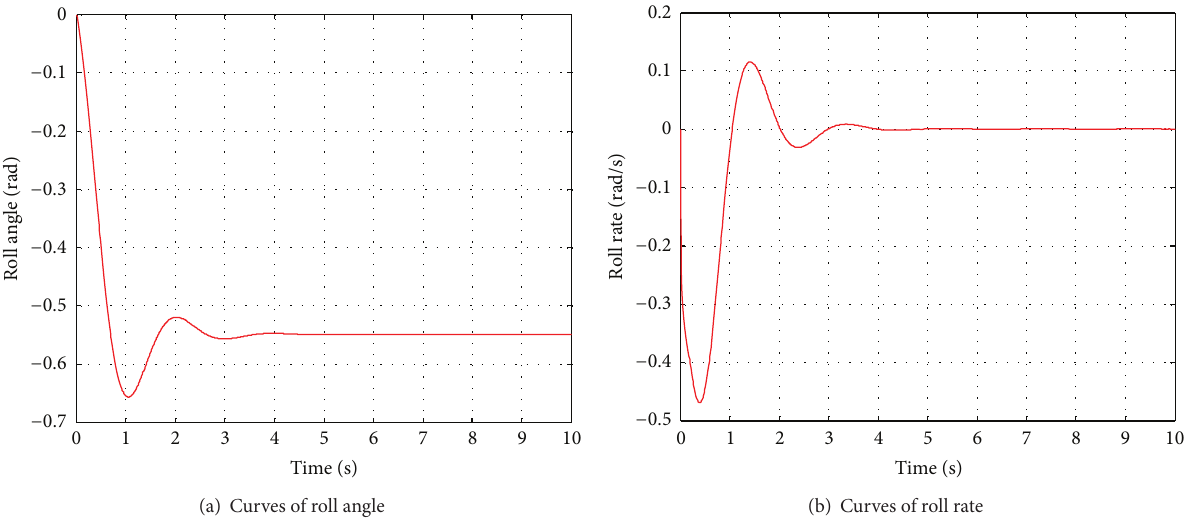
Figure 14: Driving stability of normal truck that is 80%